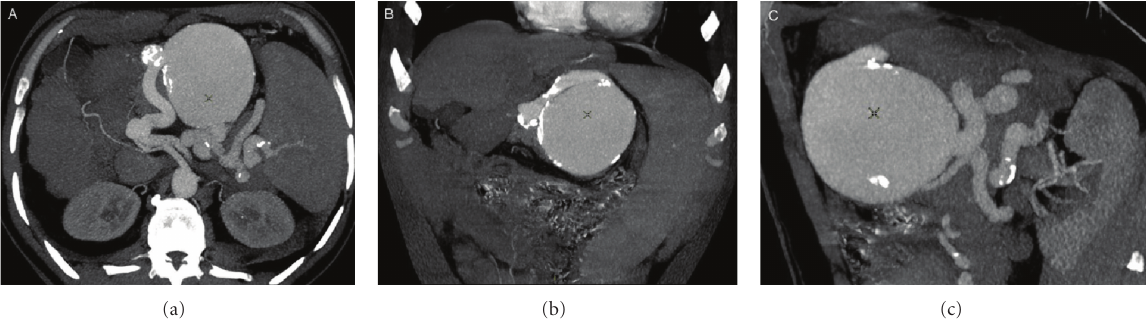
Figure 1: Computed tomography (CT) of the abdomen showing a tortuous and ectasic splenic artery with some widely dilated sections (max 24mm calibre) and massive aneurysmal dilation in the middle tract (90mm of maximum diameter) with partly calcified walls, inducing a cranial displacement of the tail and the body of the pancreas.